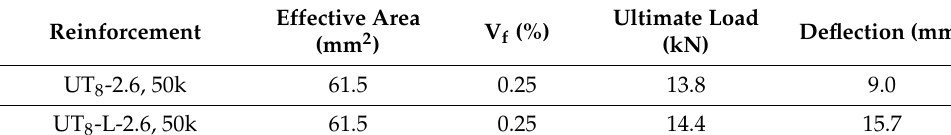
Table 5. Results of straight end tow uni-axial TRC beams.